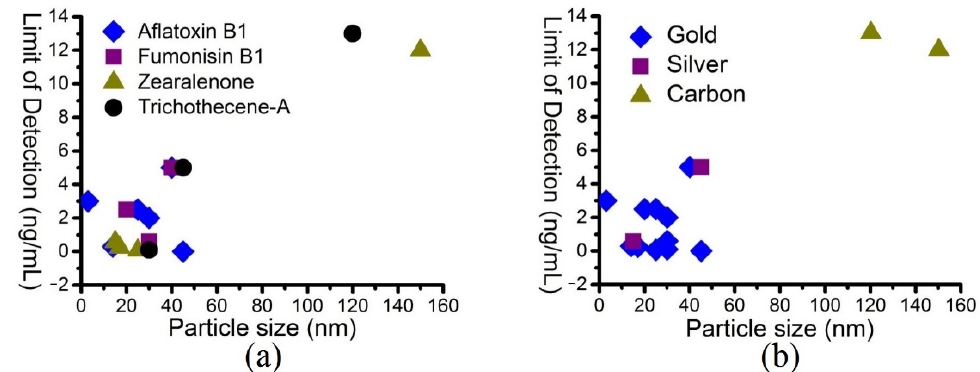
Figure 4. Nanoparticle size dependence of limit of detection on mycotoxins and materials of nanoparticles. ( a ) Different mycotoxins (Blue diamond: Aflatoxin B1; Purple square: Fumonisin B1; Green triangle: Zearalenone; Black circle: Trichothecene–A); ( b ) Different materials of nanoparticles (Blue diamond: Gold; Purple square: Silver; Green triangle: Carbon.).